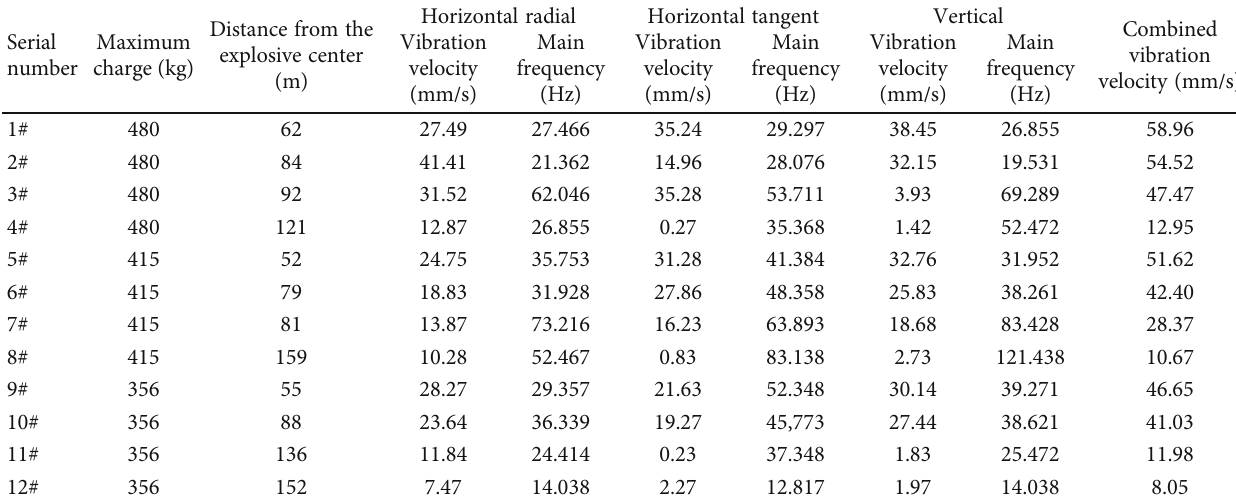
Figure 4: Velocity time history curves of no.1 measuring point in the open-pit blasting. (a) Horizontal radial and (b) vertical. Table 2: The results of blast vibration